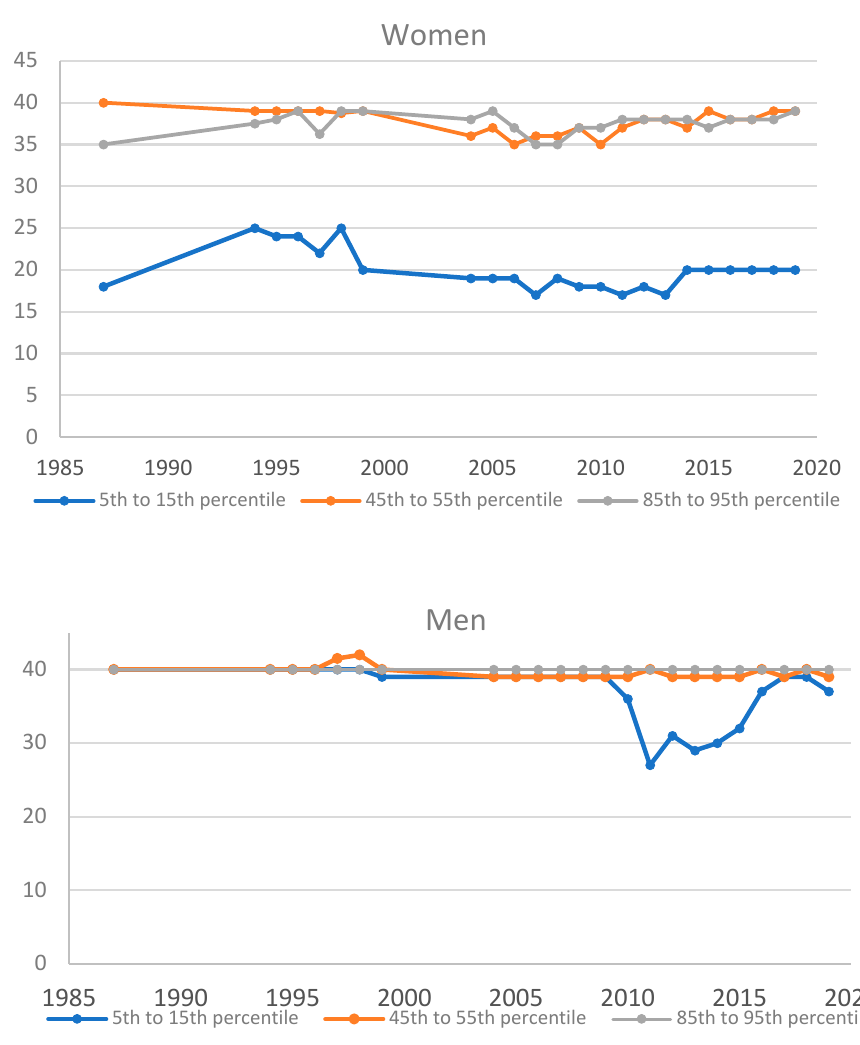
Figure 3. Hours worked by men and women across the earnings distribution. Source: Authors’ calculations using the ESRI Survey of Income Distribution, Poverty and Usage of State Services, the Living in Ireland Survey, and the European Union—Survey of Income and Living Conditions. Notes: Limited to respondents aged 25–55 and excluding the self-employed. Women around the 10th percentile of earnings have worked consistently fewer hours per week, on average, over the last 30 years than women around the 50th or 90th percentiles. In 1987, the lowest-earning women worked an average of 18 h per week. This figure rose over the next 15 years—to a high of 25 h in 1998—before falling during the financial crisis. In 2019, women around the 10th percentile of weekly earnings worked half as many hours as those around either the 50th or 90th